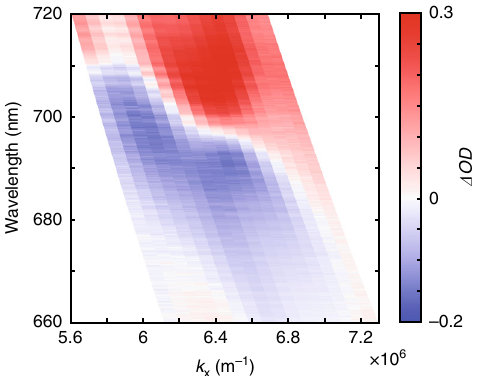
Fig. 6 Changing dynamic response with angle of incidence of control